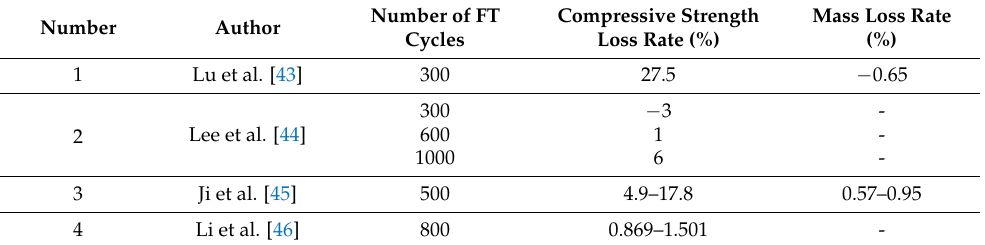
Table 5. The referred compressive strength loss rate and mass loss rate of UHPC after FT cycles.